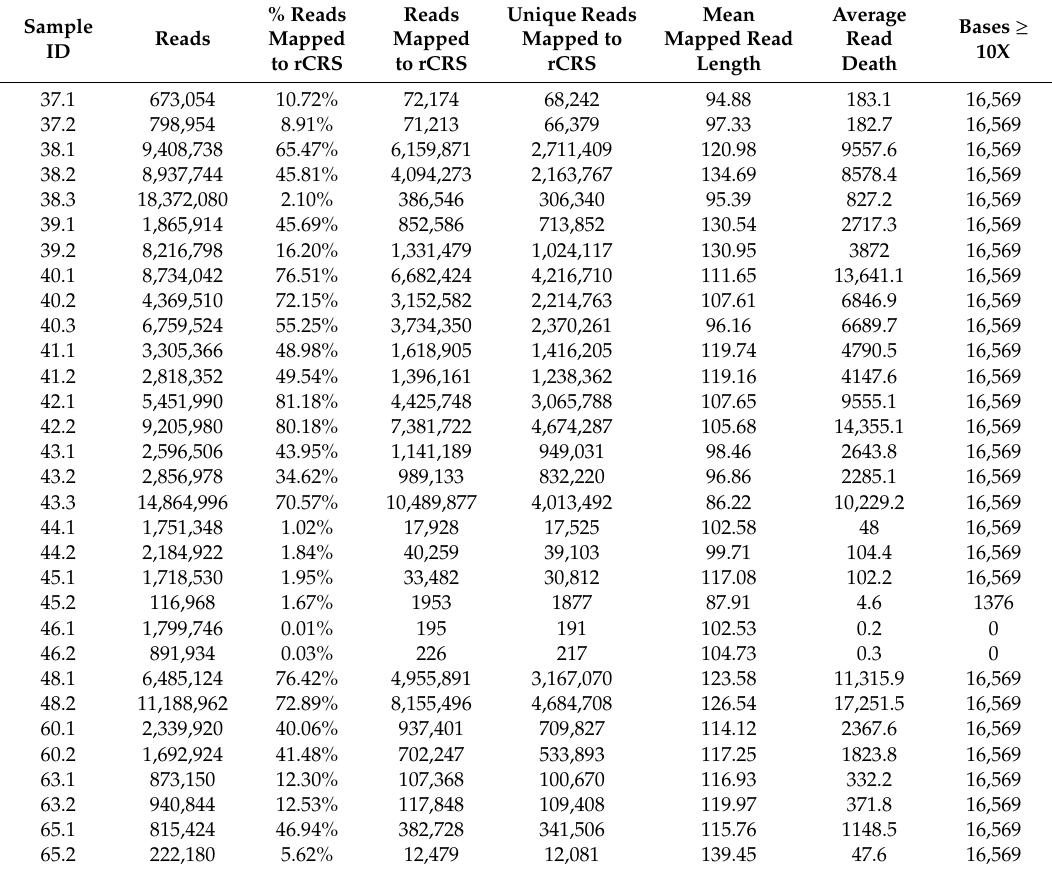
Table 1. Mitogenome sequencing results obtained from the 14 skeletal samples. The sample identification (ID) (e.g., 37.1) indicates the bone sample (37) with the DNA extract number shown after the decimal (.1 for first DNA extract). rCRS = revised Cambridge Reference Sequence